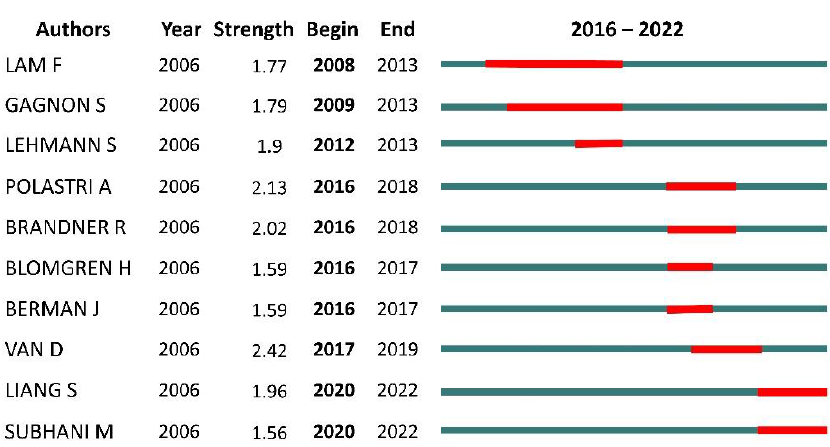
Figure 8. Author co-citation network for publications of cross-laminated timber in construction.